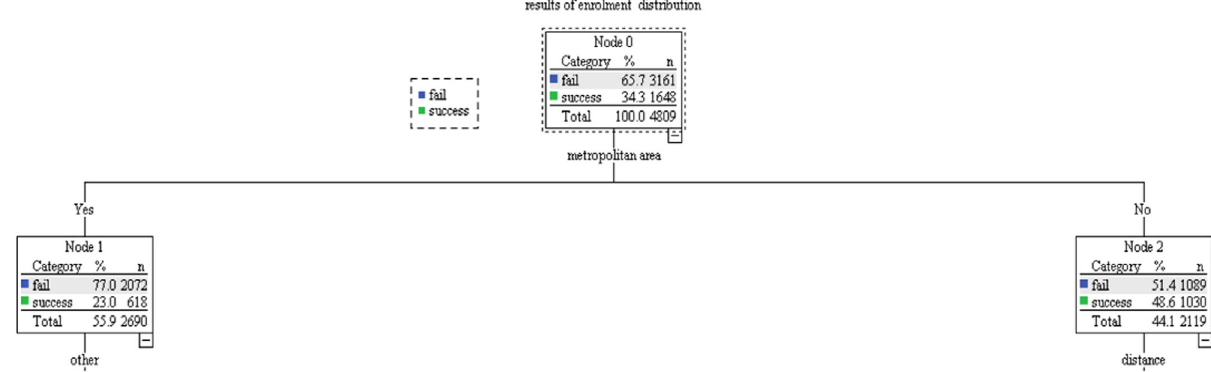
Fig. 3 A sub-tree on up for the training. A sub-tree structure of the fi rst to the second level for the training